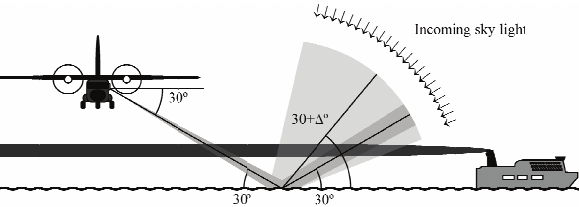
Fig. 5. Illustration of the airborne optical measurement of the ship emissions. It is assumed that the skylight is specularly reflected on the ocean surface at a slant angle of 30 ◦ corresponding to the tele- scope angle and the light hence passes twice through the gas plume. The presence of waves widens the field of view observed and causes an uncertainty in the angle by which the light passes through the gas plume.